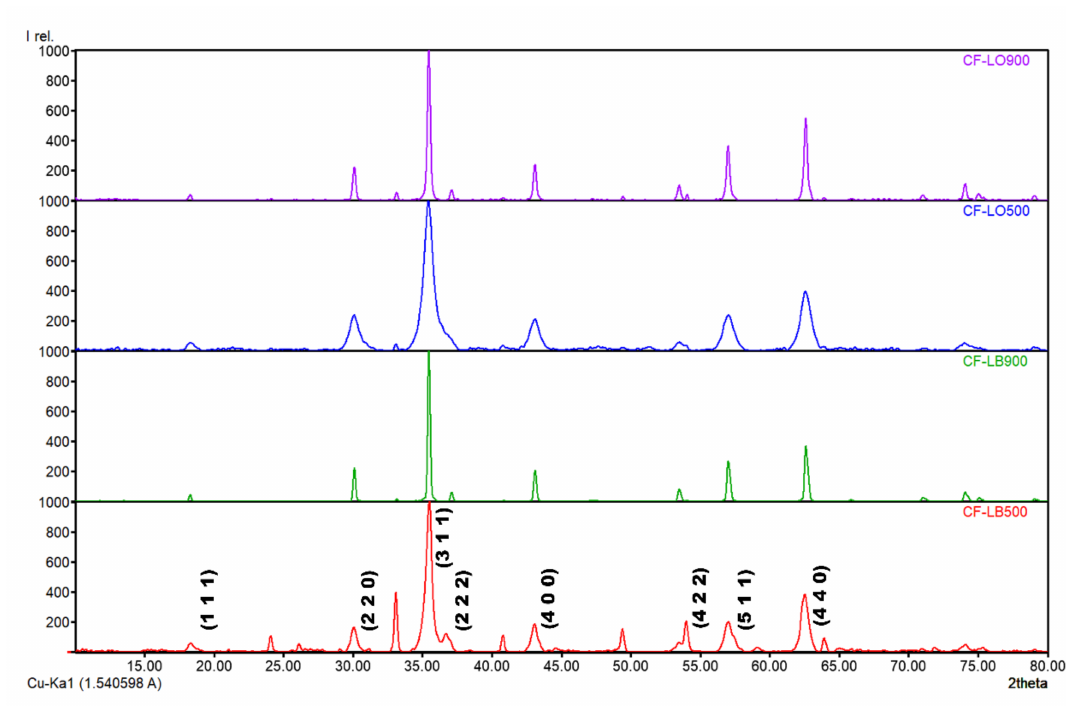
Figure 2. XRD spectra of lignin